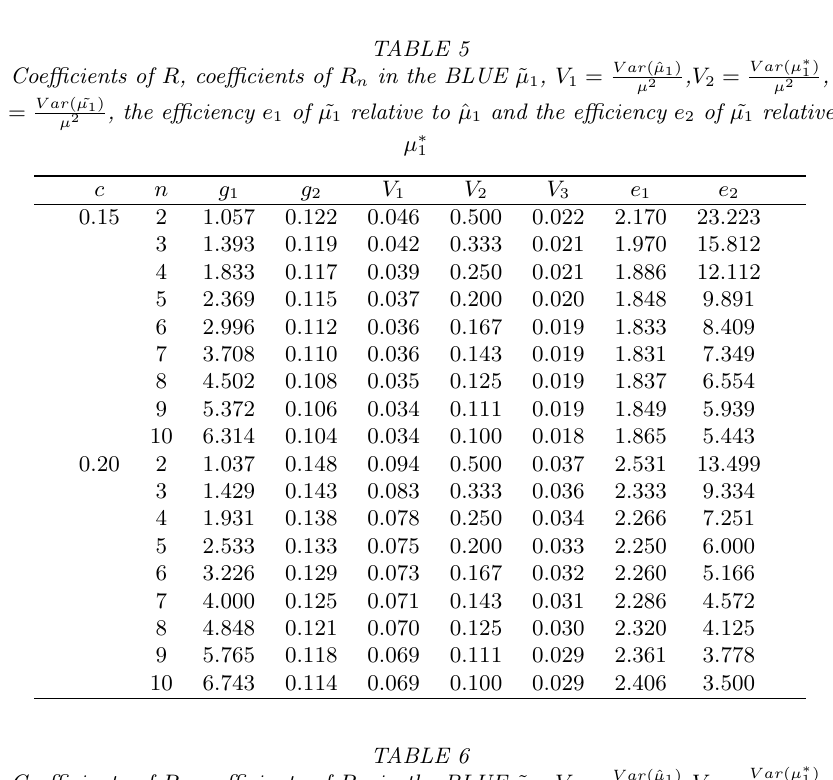
Coefficients of R , coefficients of R n in the BLUE ˜ (cid:22) 1 , V 1 = V ar (^ (cid:22) 1 )